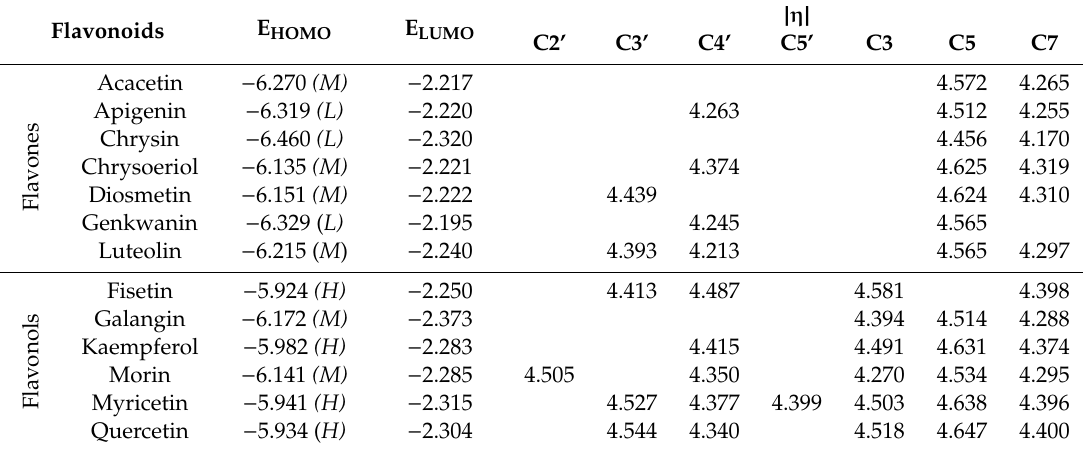
Table A1. Energies of HOMO, LUMO and chemical hardness of investigated flavonoids